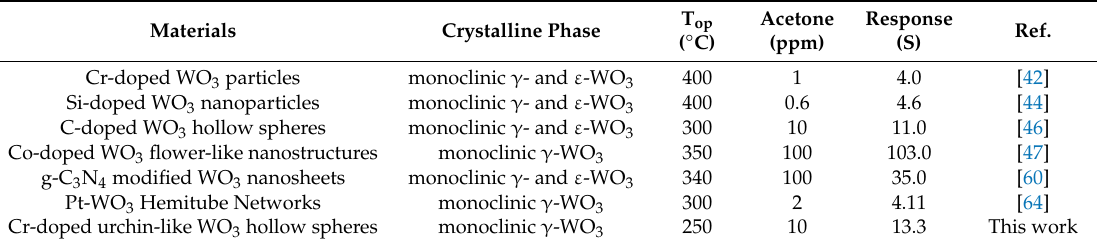
Table 1. Comparison of gas-sensing properties of sensors based on various sensing materials toward acetone.